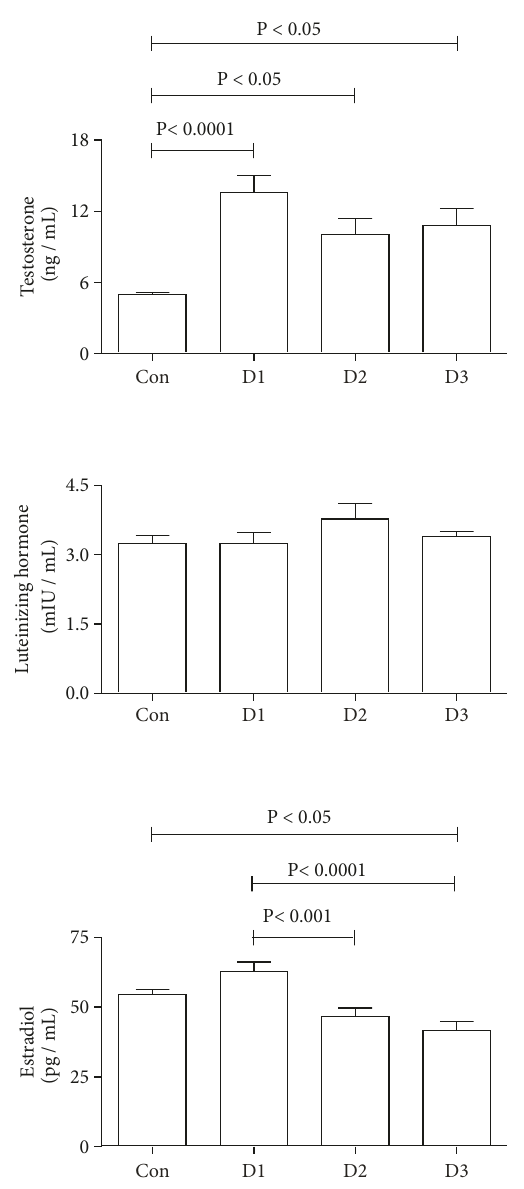
Figure 4: Effect of date pit extracts on testosterone, luteinizing hormone (LH), and estradiol levels in mice. The column and vertical bar represent the mean ± SEM ( n � 6). Extracts (100mg/ kg): D1: lyophilized; D2: nonpolar fraction; and D3: polar fraction. These extracts were given to mice throughout the experiment by oral gavage. On treatment day 28, the mice were sacrificed for plasma collection. Con: control. Differences between the groups were assessed by one-way analysis of variance (ANOVA) followed by Bonferroni’s multiple comparison test, where P < 0 .